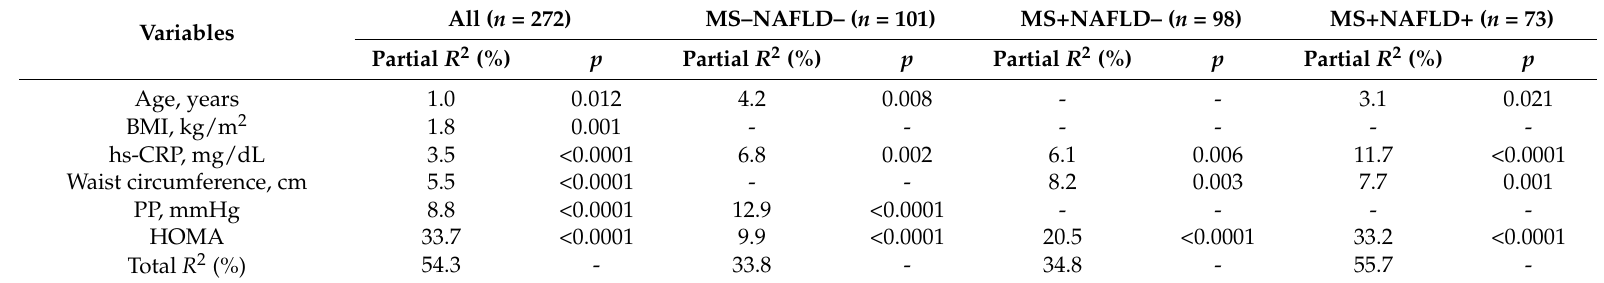
Table 3. Stepwise multiple regression analysis FBF as a dependent variable in the whole study population and in different